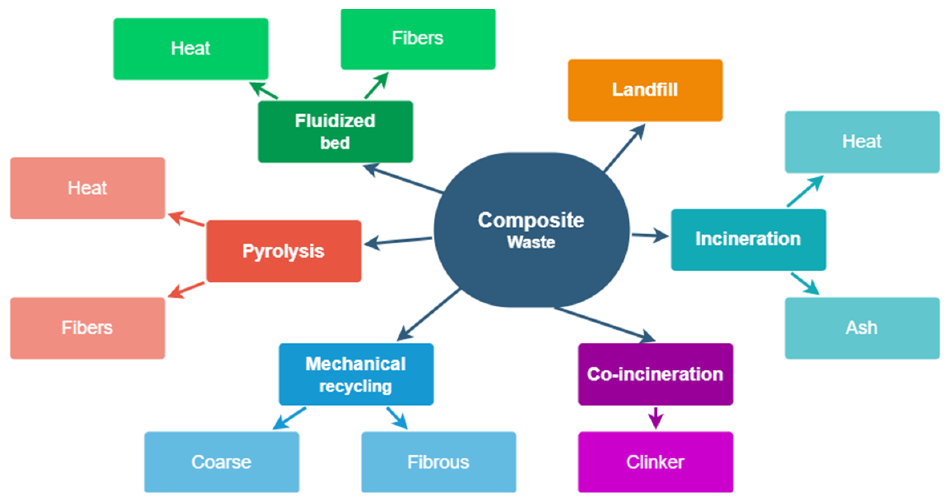
Figure 12. End-of-life pathways for FRP composites.